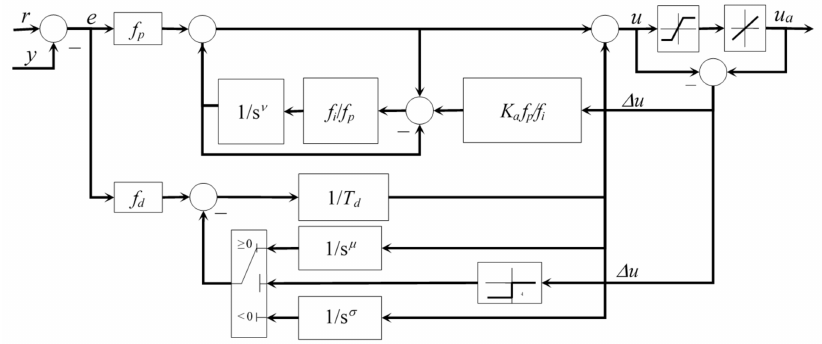
Figure 14. Anti-windup concept taking advantage of the fractional order approach.